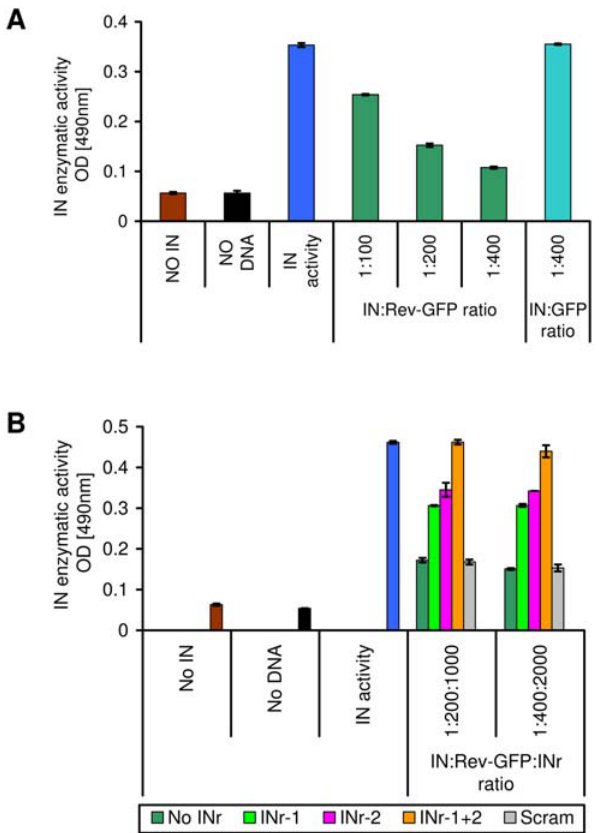
Figure 2. Inhibition of IN enzymatic activity by Rev and its abrogation by the INr peptides. (A) Rev-GFP (dark green) or GFP (turquoise) were incubated at different molar ratios with IN (390 nM) and the IN enzymatic activity was determined as described